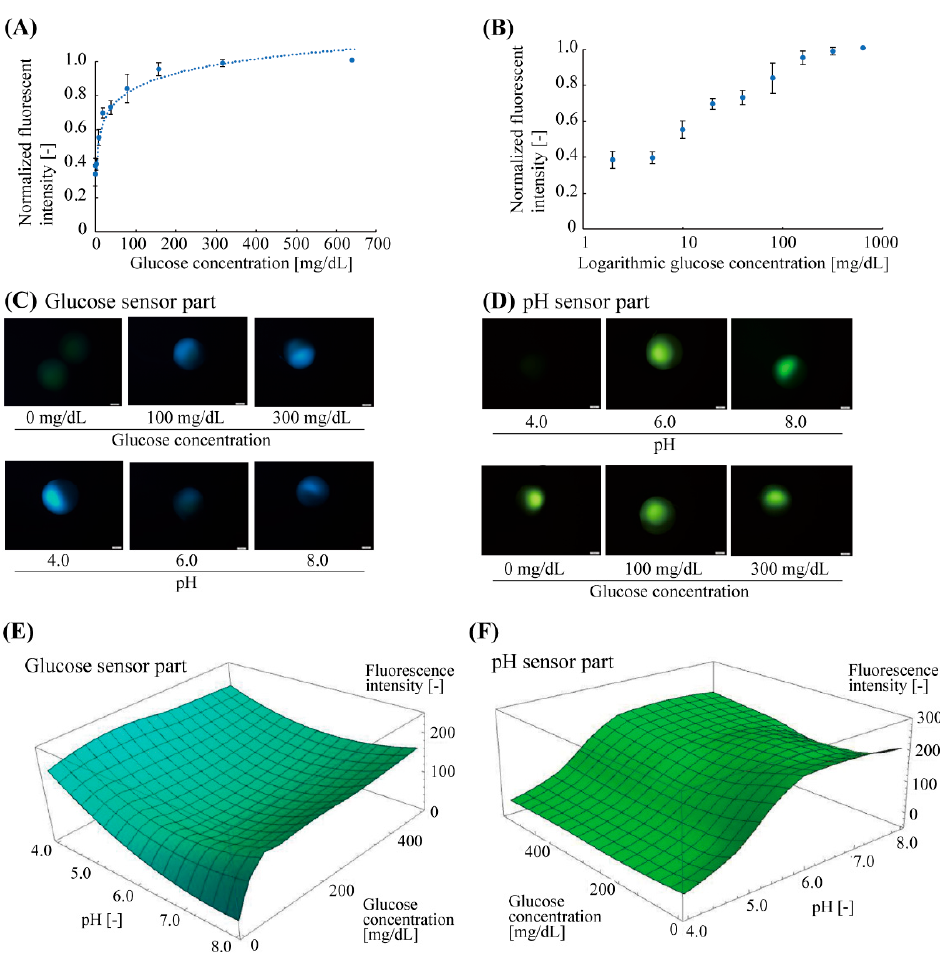
Figure 4. Fluorescent characteristics of glucose and pH sensor parts of the microbeads. ( A ) Rela- tionship between normalized fluorescence intensity and glucose concentration of the glucose sensor parts at neutral pH (pH 7.0). The plots and error bars indicate the mean and standard deviation, respectively ( n = 4). The dotted curve is a logarithmic correlation curve. ( B ) Semi-logarithmic plot of ( A ). The approximate measurable range of the glucose concentration with the microbead sensor were 10–320 mg/dL. ( C ) Fluorescent images of glucose sensor part in various glucose concentrations (0–300 mg/dL, pH 7) and pH conditions (pH 4.0–8.0, 200 mg/dL glucose) ( D ) Fluorescent images of pH sensor part in various pH conditions (pH 4.0–8.0, 500 mg/dL glucose) and glucose concentrations (0–300 mg/dL, pH 6). ( E , F ) Fluorescent characteristics of the glucose and pH sensor parts for varied pH and glucose concentrations.